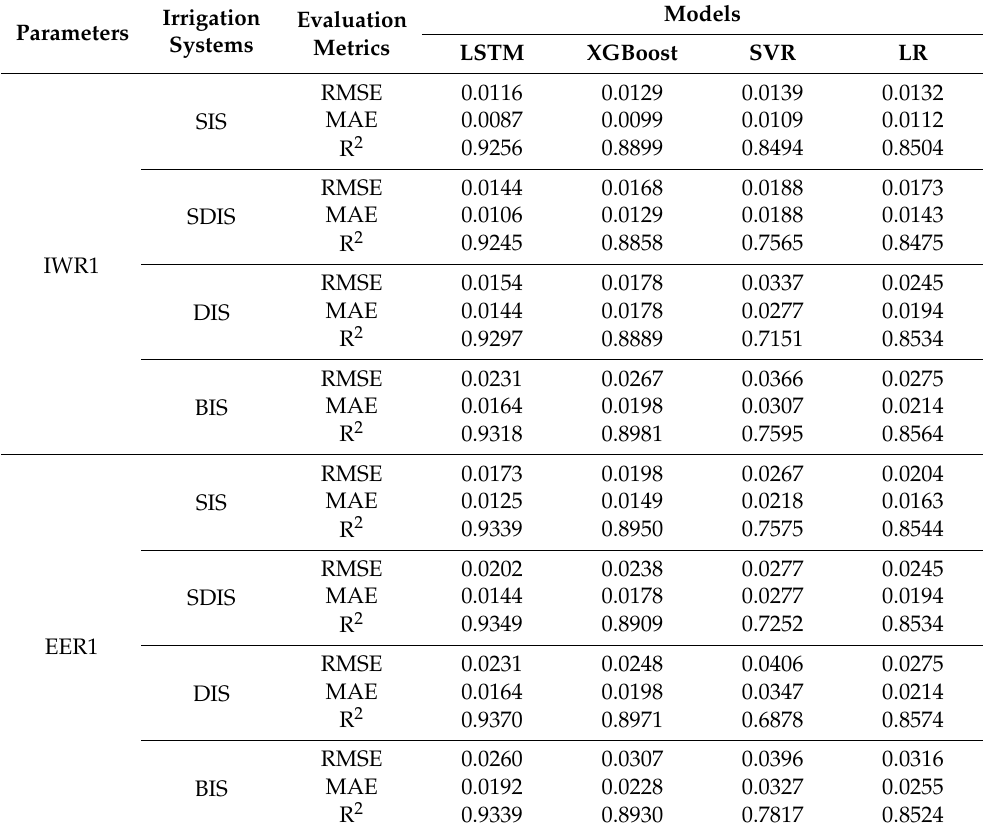
Table 5. Comparison among evaluation values of three performance metrics for ML models based on the testing dataset for predicting the irrigation water requirements (IWR1) and the electrical energy requirements (EER1) when the target is to achieve the optimum water use efficiency using different solar-powered micro irrigation systems based on limited meteorological data, i.e., average temperature, RH, wind speed, solar irradiance, and date palm age.